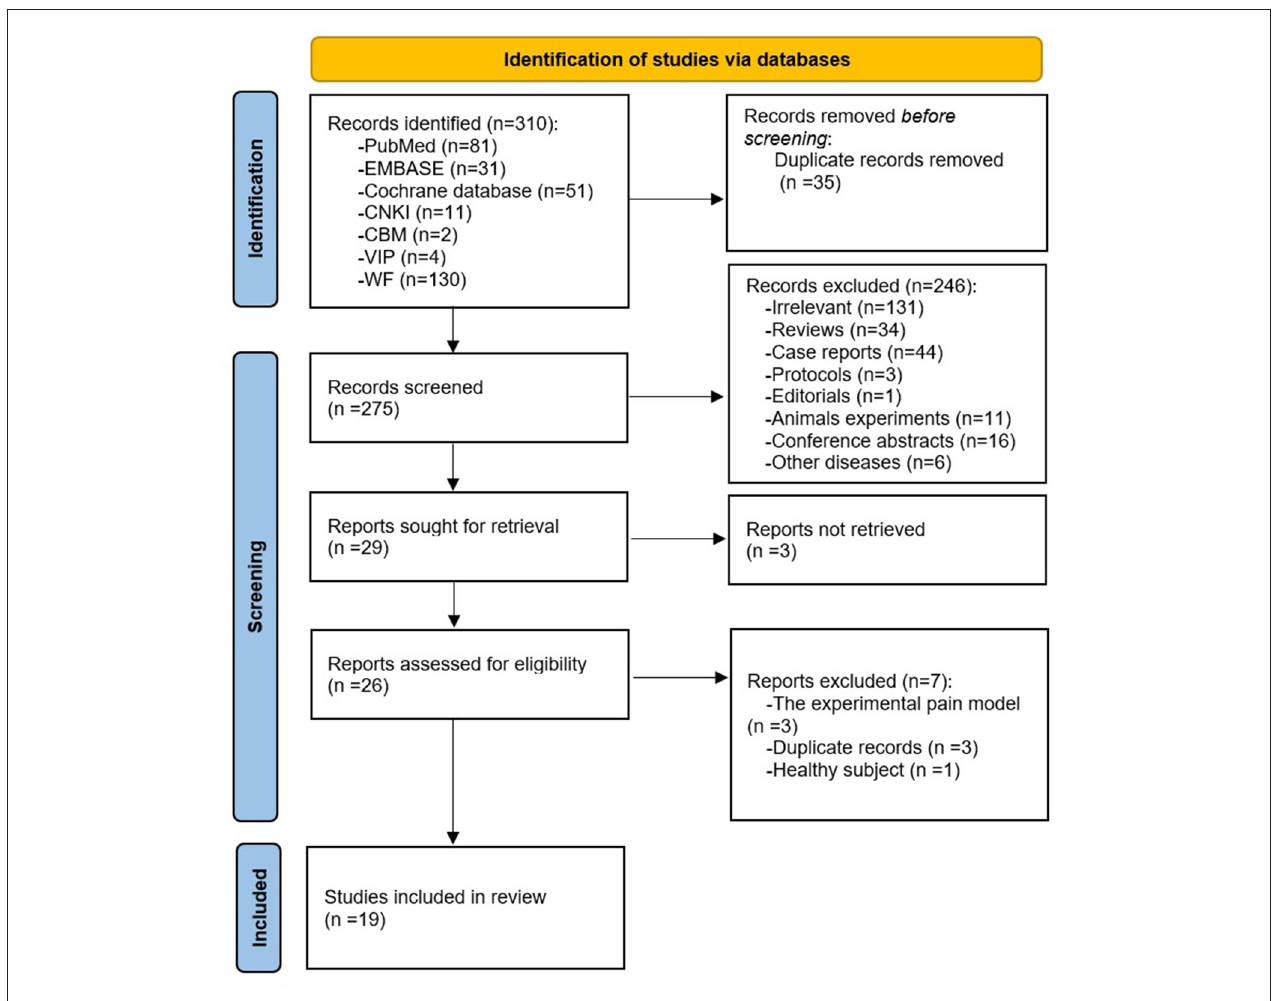
FIGURE 1 | The flow diagram of literature search and screening